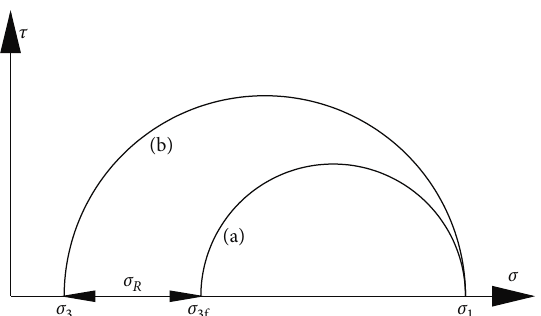
Figure 8: Variation of lateral stress of filling body under the same normal stress.